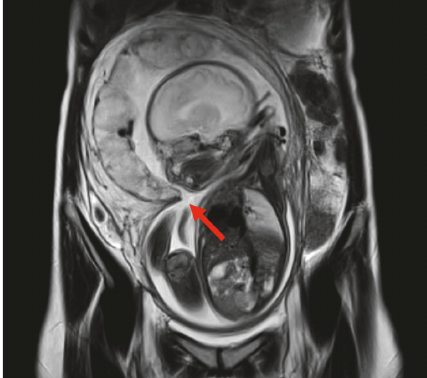
Figure 1: Semicircular stenosis, thought to influence adhesions in the uterus, was confirmed, and amniotic membrane sheets (tissues with a free edge visualized within the amniotic cavity) were identified (arrow).